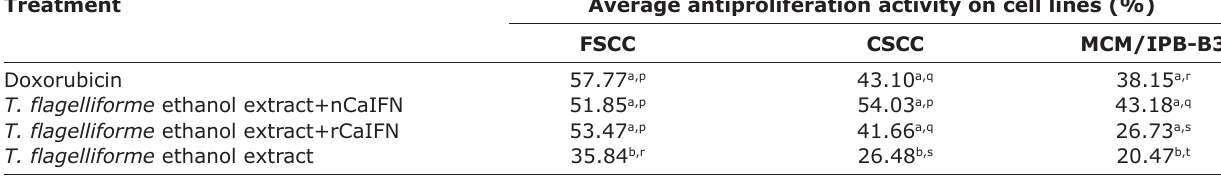
Table-2: Antiproliferation activity of the treatments in each cell lines.